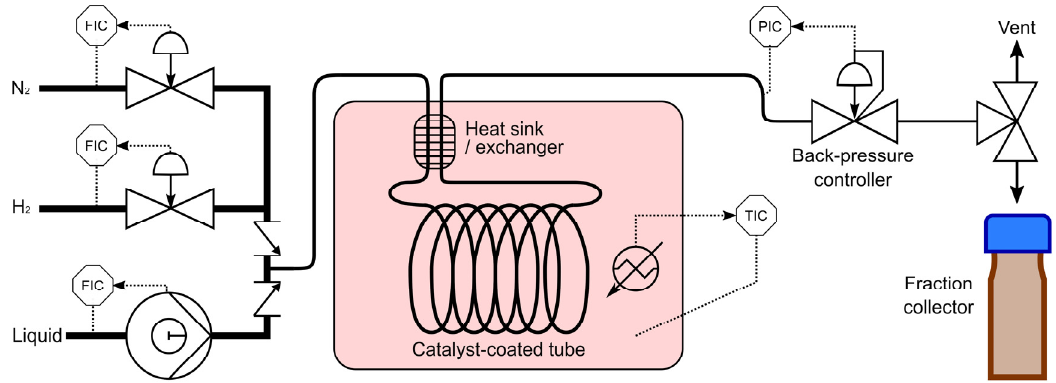
Figure 10. Scheme of the experimental set ‐ up used for testing catalyst ‐ coated tubes.